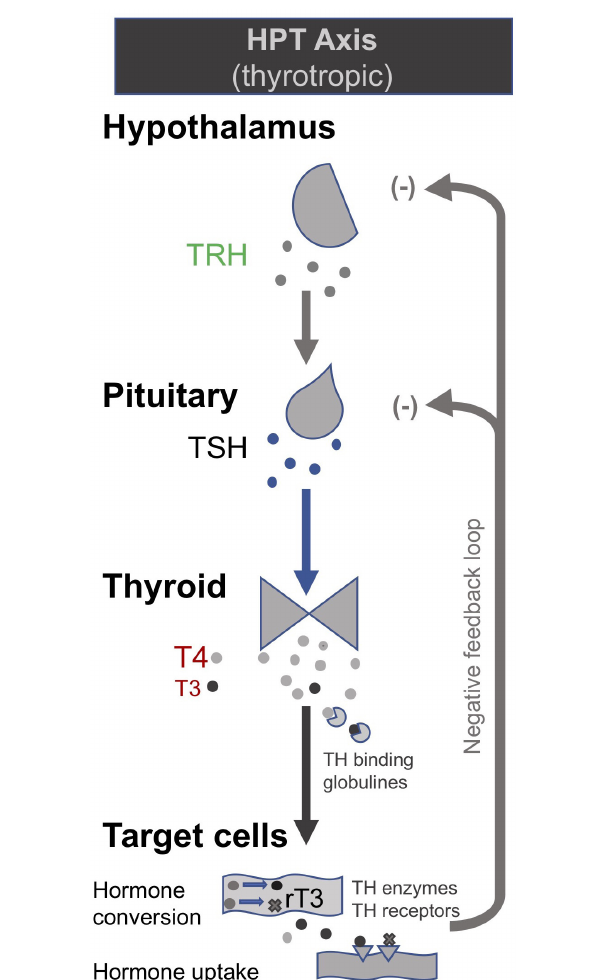
FIGURE 3 | The thyrotropic (HPT axis) [modified from